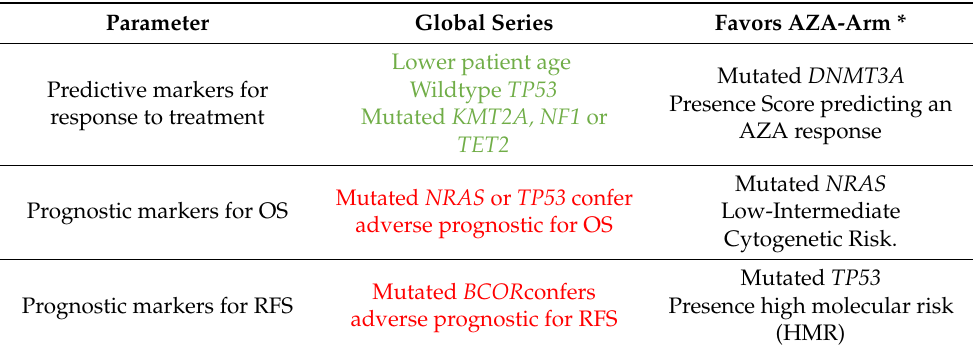
Summary table of biomarkers identified in a phase 3 AML trial of azacitidine (AZA) vs. low dose cytarabine plus fludarabine (FLUGA). * Green: predictors of favorable response. Red: predictors of adverse outcome. HMR: high-molecular-risk pattern defined by the presence of NRAS and/or TP53 mutations. Score predicting an AZA response defined by presence of DNMT3A , TET2 , EZH2 , or U2AF1 mutations * subtypes which benefit from the AZA arm vs. LDAC+ fludarabine based on biological and genomic characteristics. AML: acute myeloid